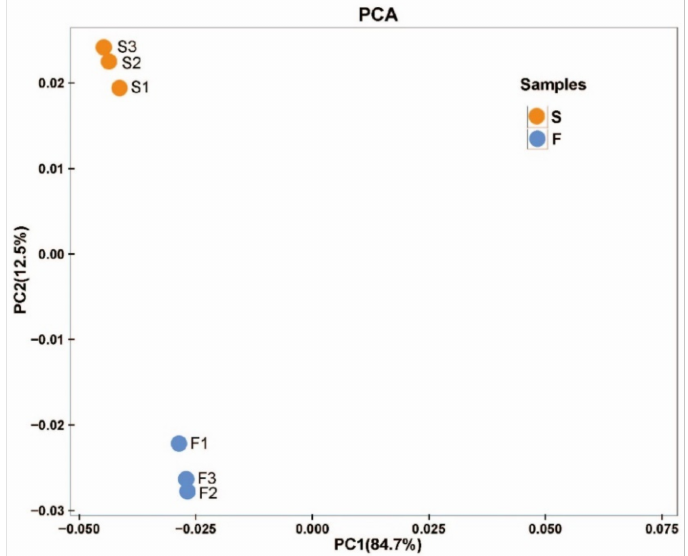
Figure 6. PCA analysis of the principal components in F and S cell lines of Korean pine. Note: The X-axis represents the first principal component, and the Y-axis represents the second principal